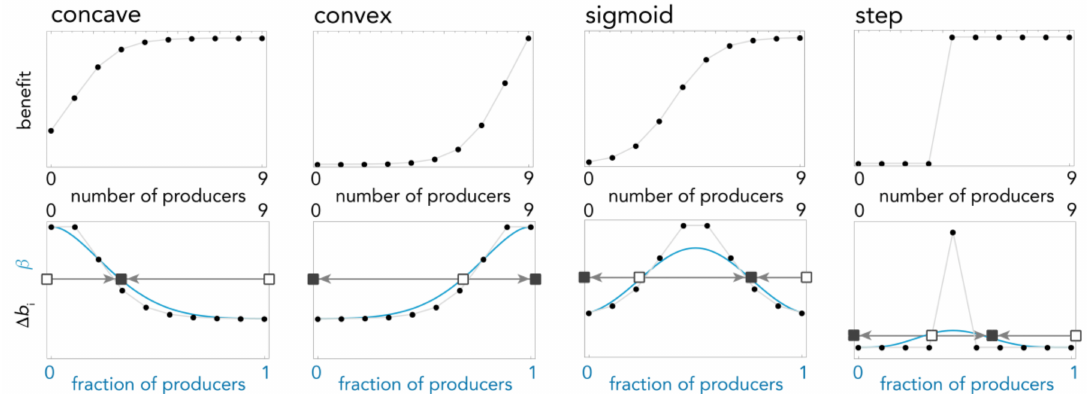
Figure 2. The gradient of selection β (bottom panels, continuous blue line) and its Bernstein coefficient ∆ b i (bottom panels, dotted line) for different types of benefit functions (top panels): concave ( n = 9, h = 0.1, s = 10, c = 0.1); convex ( n = 9, h = 0.9, s = 10, c = 0.1); sigmoid ( n = 10, h = 0.4, s = 9, c = 0.1); step function ( n = 9, h = 0.4, s = 1000, c = 0.1). Arrows show the direction of the dynamics (determined